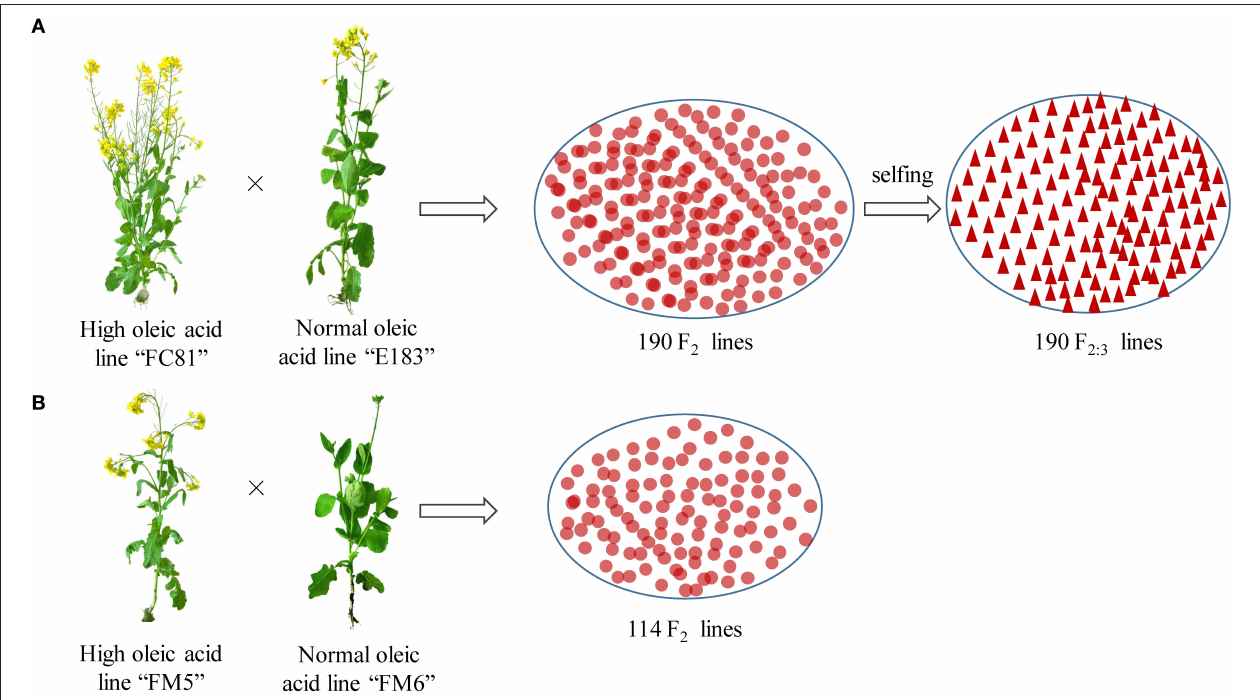
FIGURE 1 | Experimental material and crossing design. (A, B) Represent the QTL mapping population and validation population, respectively.